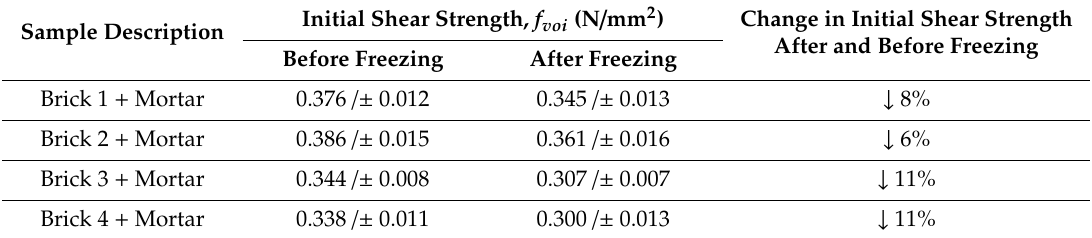
Table 5. Initial shear strength of wall samples prior and after their exposure to freeze / thaw cycles.